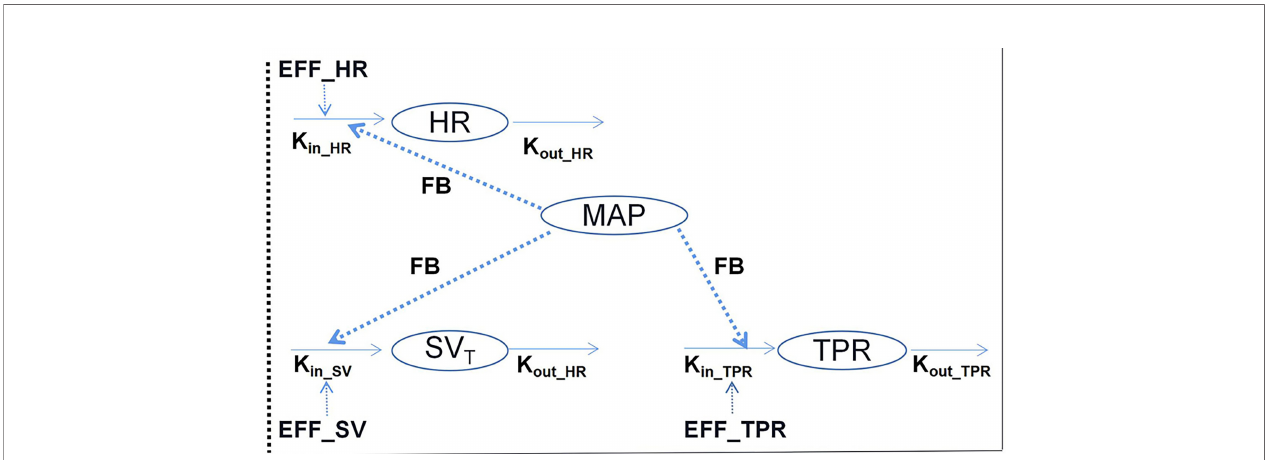
FIGURE 3 | Illustrative structure of the hemodynamic system pharmacology model developed by Snelder et al. (23). HR, heart rate; TPR, total peripheral resistance; MAP, mean arterial pressure; and SV, stroke volume. FB- represents the negative feedback mechanism through MAP. The effects on HR, SV, and TPR are described using turnover models. K in_HR , K in_SV , and K in_TPR represent the zero-order production rate constants and k out_HR , k out_SV , and k out_TPR represent the fi rst- order elimination rate